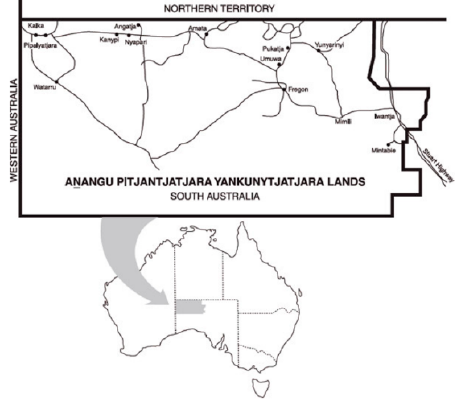
Figure 1. Map showing the Anangu Pitjantjatjara Yankunytjatjara (APY) Lands.